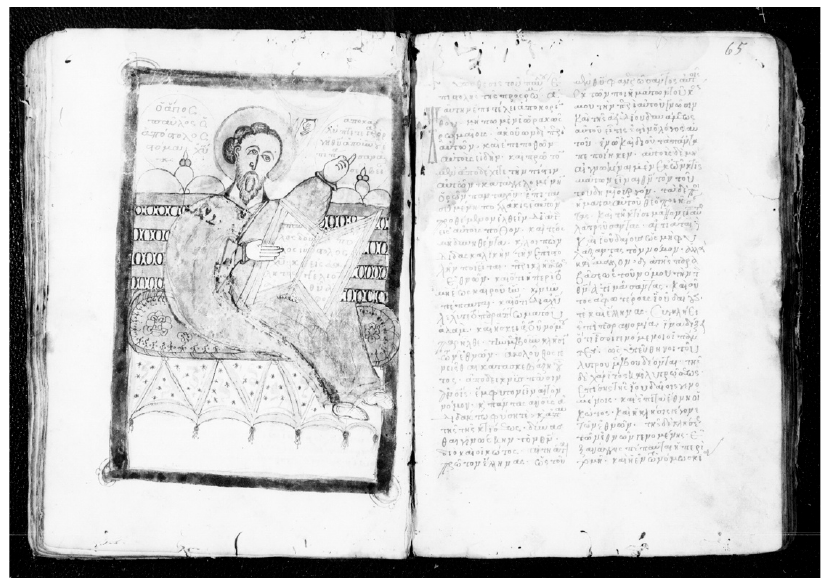
Figure 3. Image of the Apostle Paul. Monastery of the Lavra (Mount Athas) K.190. f. 64v (GA